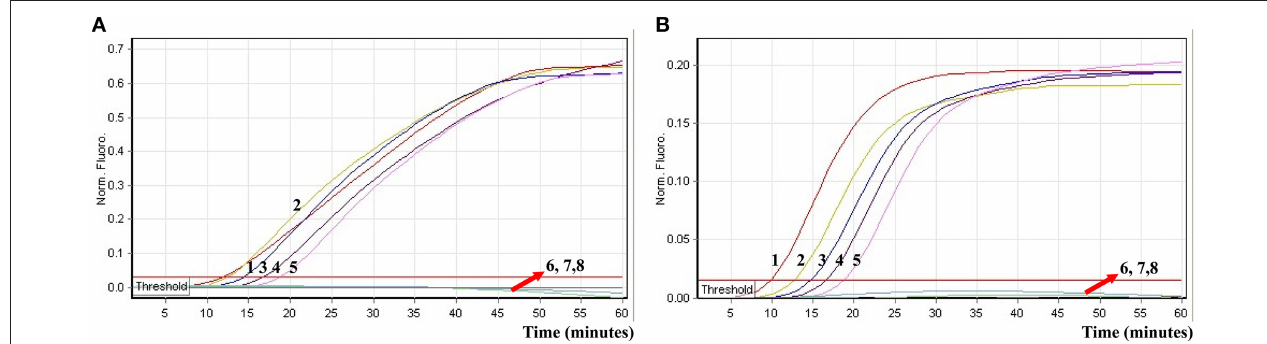
FIGURE 10 | The sensitivity of multiplex ET-MCDA approach for simultaneously detecting two target pathogens in artificially contaminated blood samples. Two sets of ET-MCDA primers targeting invA and ipaH genes were simultaneously added to a reaction vessel. (A,B) were simultaneously yielded from Cy5 (labeling Sal -E-CP1 of invA ) and Hex (labeling Shi -E-CP1 of ipaH ) channels, respectively. Sensitivity of multiplex-ET-MCDA for simultaneously detecting Salmonella (A) and Shigella (B) in artificially contaminates blood samples was monitored by real-time format, and signals 1, 2, 3, 4, 5, 6, 7, and 8 represent Salmonella DNA levels of 39,000, 3900, 390, 39, 3.9, 0.39, and 0.039 CFU per reaction and negative control; Salmonella DNA levels for 34,000, 3400, 340, 34, 3.4, 0.34, and 0.034 CFU per reaction and negative control. The LoD of multiplex ET-MCDA method for Salmonella analysis in artificially contaminates blood samples was 3.9 CFU per reaction, and the LoD of multiplex ET-MCDA for Salmonella detection in artificially contaminates blood samples was 3.4 CFU per reaction.